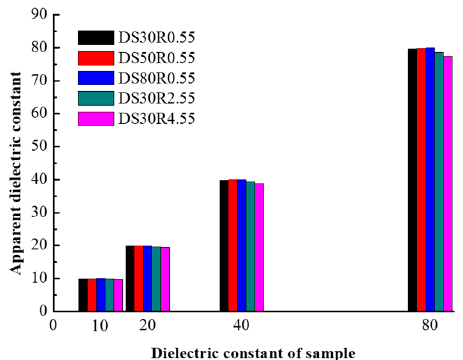
Figure 8. Relationship between the apparent dielectric constant and the dielectric constant of the sample. The diameter of sample (DS) ranges from 30 to 80 mm and the diameter of rod (R) varies from 0.55 to 4.55 mm. For instance, for DS30R0.55 the diameters of the sample and probe rod in the model are 30 mm and 0.55 mm, respectively.